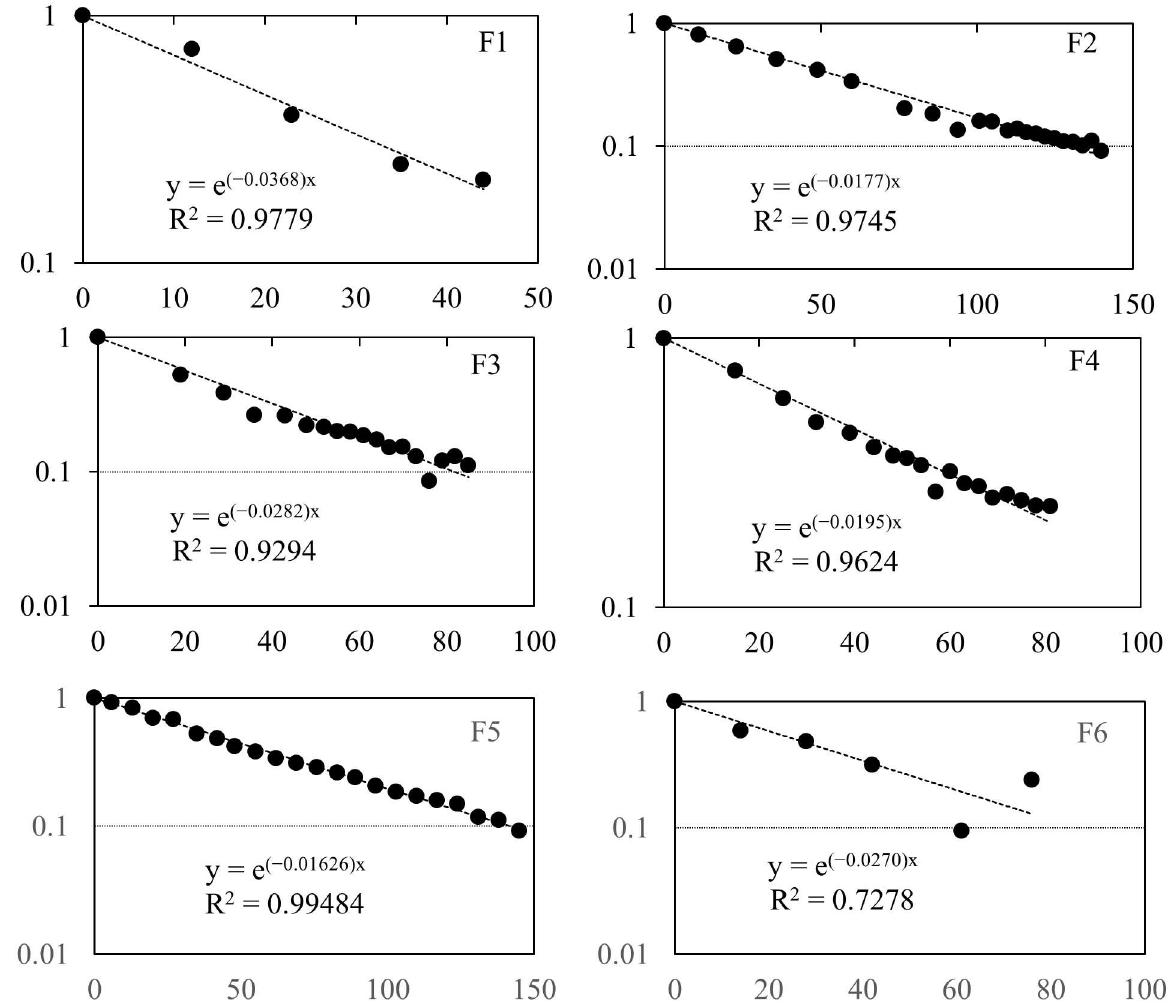
Fig 4. The decay curves of radiocesium ( 137 Cs) in feline bodies. The graph shows the relativeconcentration in the wholebody versus the numberof days elapsedsince the first measurement date. Each regressionequationand the coefficient of determination are